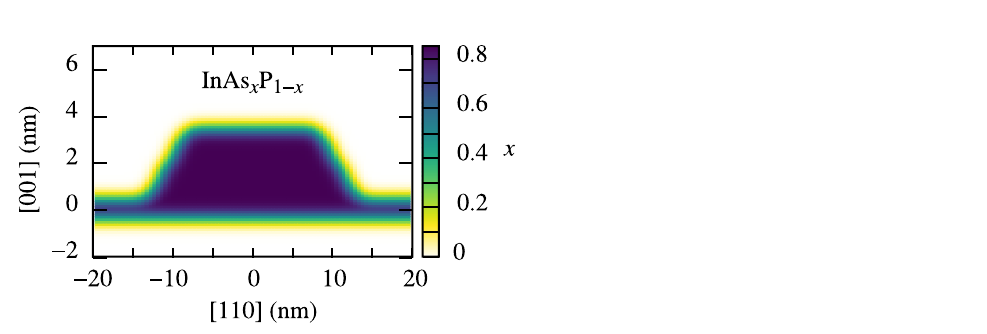
Figure 1. Geometry of modeled QDs. Schematic presentation of the InAs/InP ( a ) and InAs/AlGaInAs ( b ) QD geometry. Wetting layers are not shown.